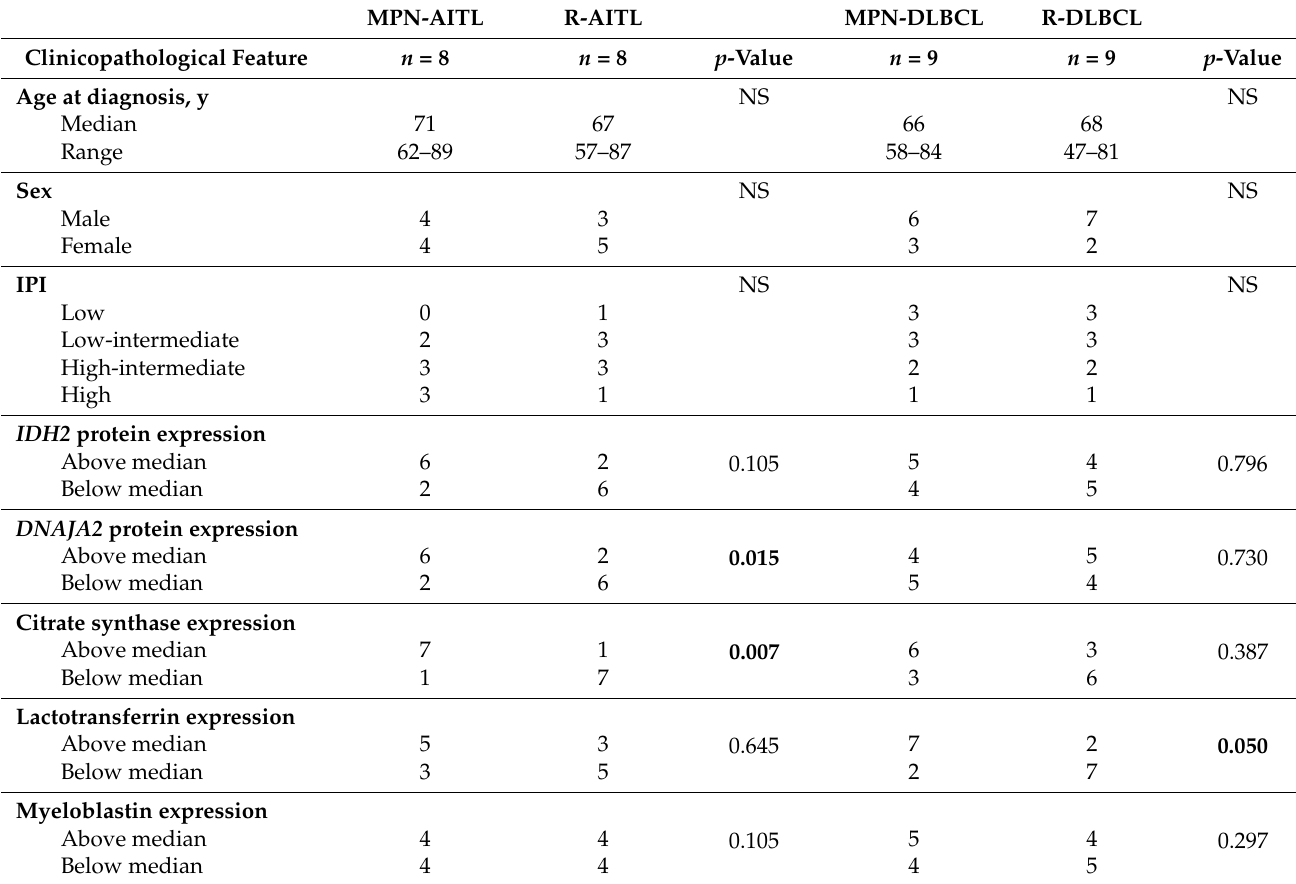
Table 1. Clinicopathological